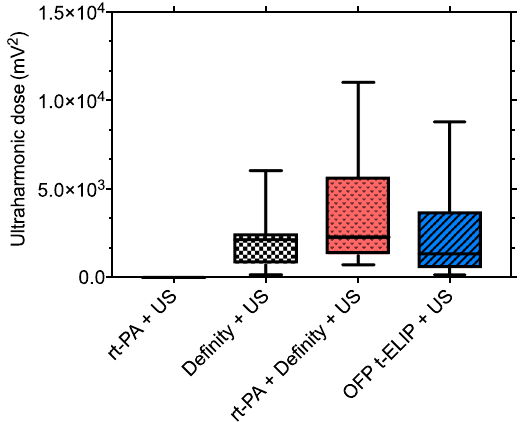
Figure 4. The ultraharmonic dose obtained with plasma alone, OFP t-ELIP, and Definity in response to intermittent ultrasound (n = 16 per group). The boxes represent the interquartile range, the horizontal lines within the boxes represent the median values, and the whiskers represent 1.5 times the interquartile range. For each group, n = 16 clots were tested. All groups were significant relative to rt-PA + US ( p < 0.01). No difference was found between the ultraharmonic dose achieved from OFP t-ELIP and Definity ( p > 0.05).